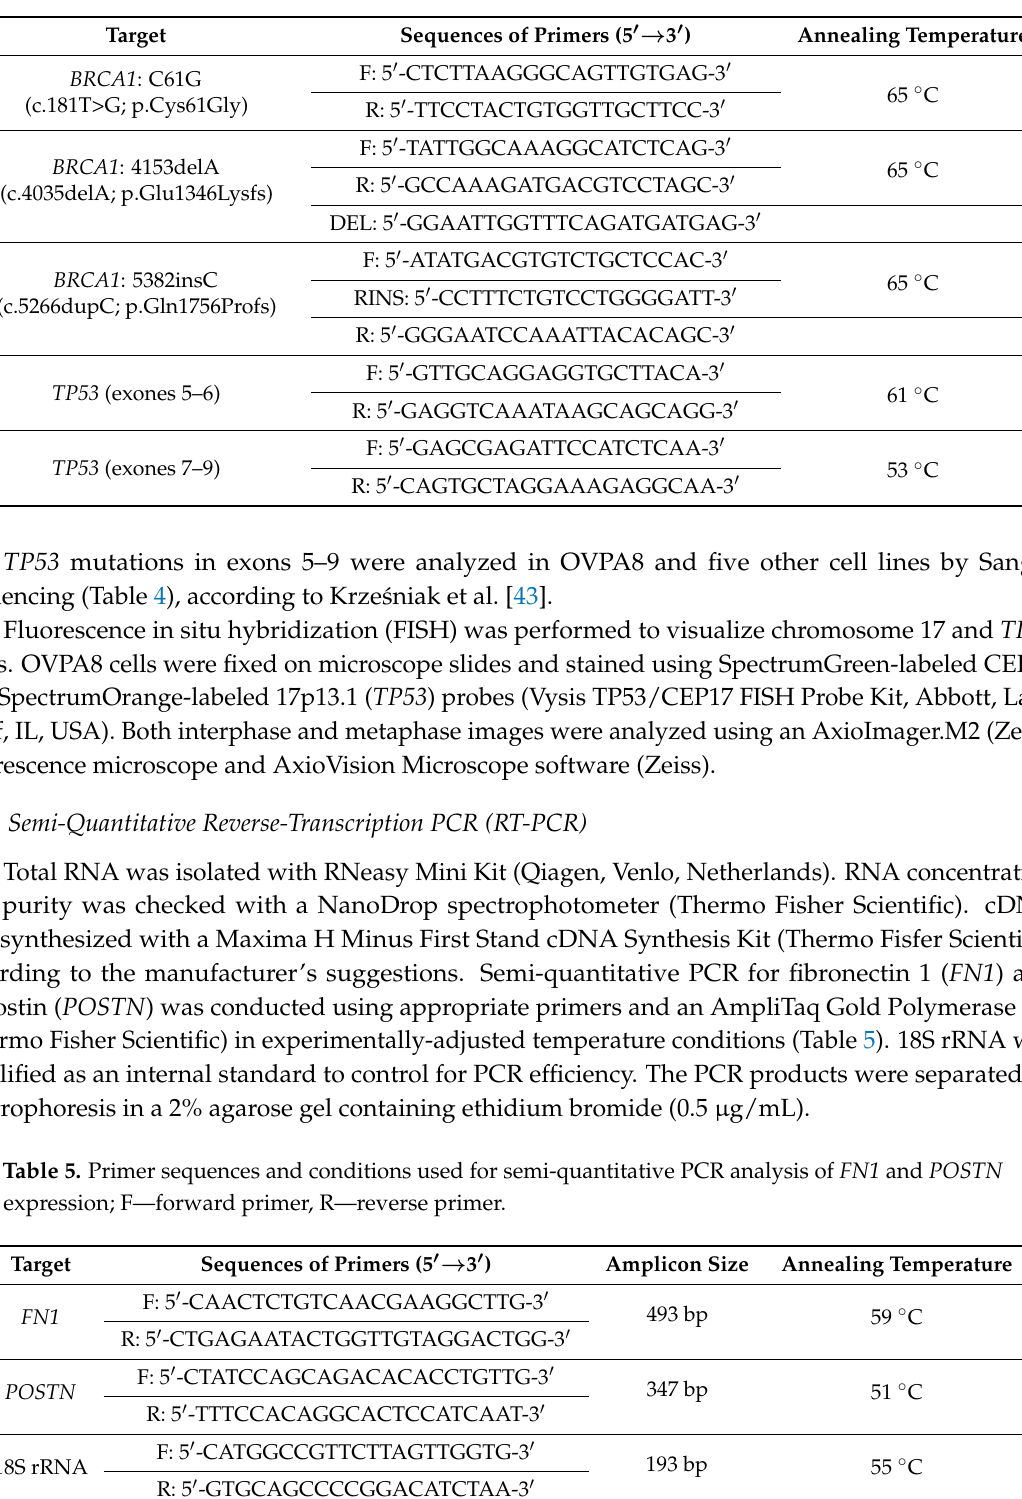
Table 4. Primers and conditions used for analysis of mutations in BRCA1 and TP53 genes; F—forward primer, R—reverse primer.